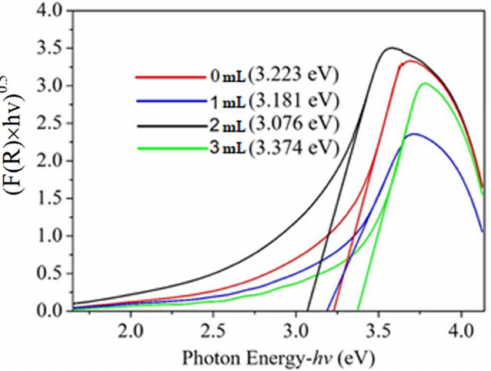
Figure 9. Band gap energy for the mixed Acac (0, 1, 2, and 3 mL) with a TiO 2 mesoporous layer, corresponding to Figure